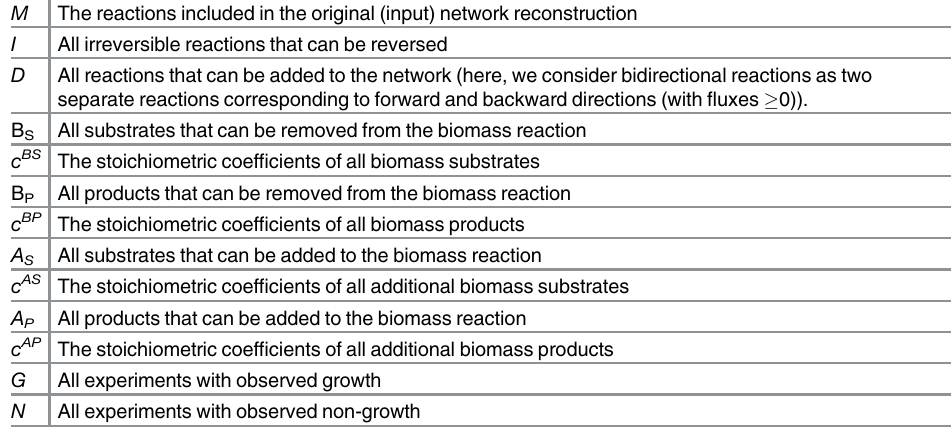
Table 9. Definitions of the sets used in the system of equations that describes the GlobalFit algorithm. M The reactions included in the original (input) network reconstruction I All irreversible reactions that can be reversed D All reactions that can be added to the network (here, we consider bidirectional reactions as two separate reactions corresponding to forward and backward directions (with fl uxes (cid:5) 0)). B S All substrates that can be removed from the biomass reaction c BS The stoichiometric coef fi cients of all biomass substrates B P All products that can be removed from the biomass reaction c BP The stoichiometric coef fi cients of all biomass products A S All substrates that can be added to the biomass reaction c AS The stoichiometric coef fi cients of all additional biomass substrates A P All products that can be added to the biomass reaction c AP The stoichiometric coef fi cients of all additional biomass products G All experiments with observed growth N All experiments with observed non-growth